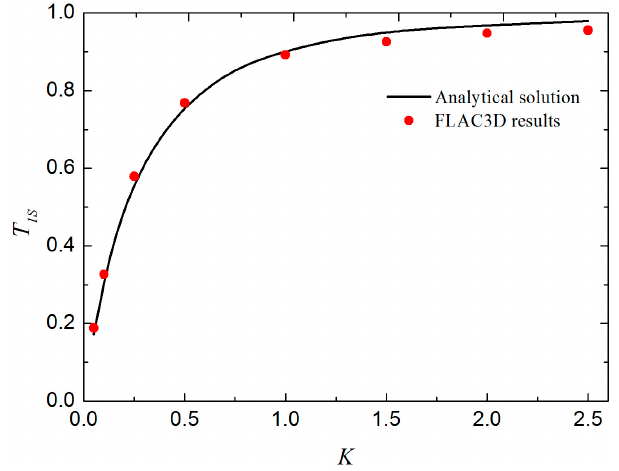
Figure 3. Relations between transmission coefficient T 1 S and normalized joint stiffness K for normally incident Sv wave transmission across a single joint.